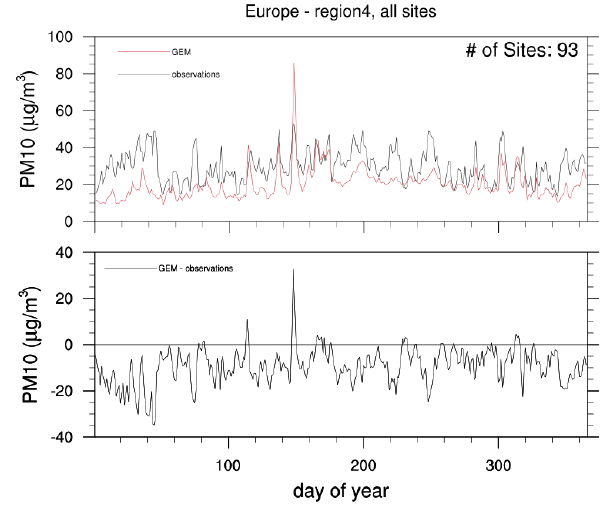
Figure 20. Time series of observed and modelled PM 10 24h con- centration averaged for all stations in western Europe and MBE.